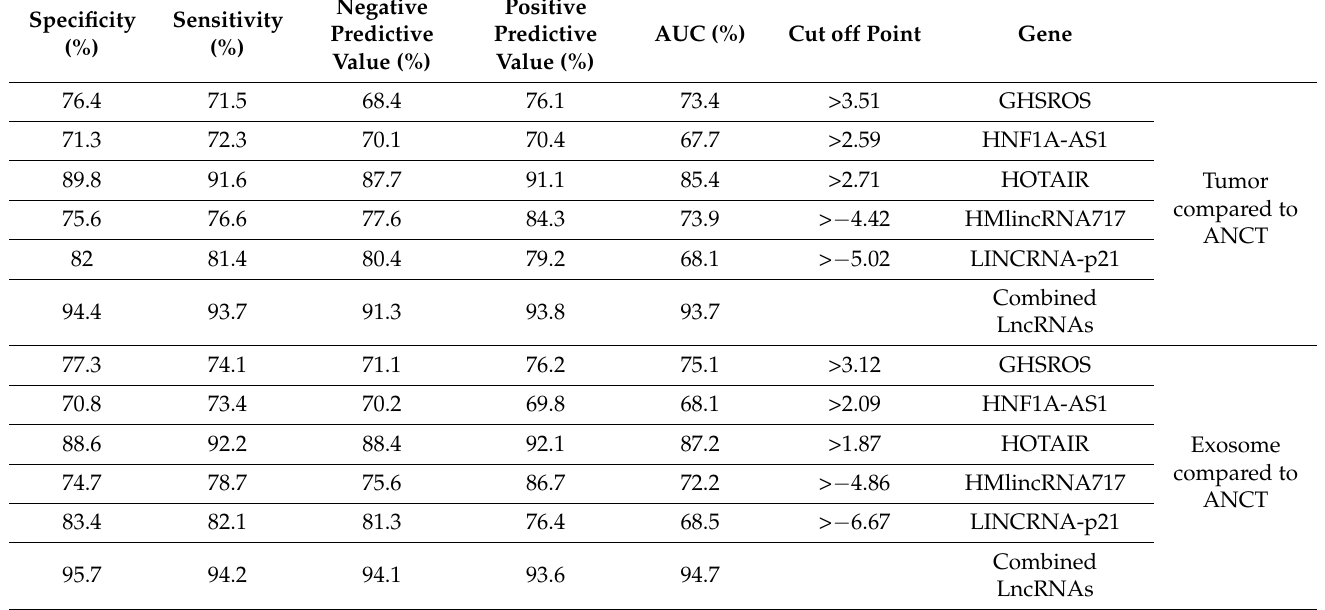
Table 5. The results of ROC curve analysis.